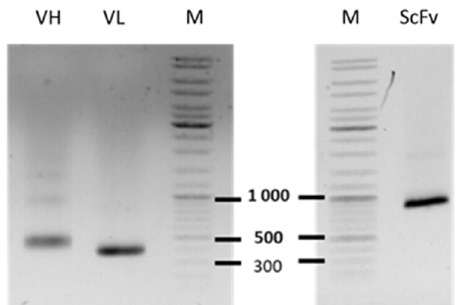
Figure 2. Visualization of PCR products on agarose gel (1.2% w / v ). VH: VH-ScFv PCR-purified product obtained after 3 rounds of PCR. VL: VL-ScFv PCR-purified product obtained after three rounds of PCR. M: Size marker 10 Kbp to 100 bp. ScFv: complete PCR insert VH + linker + VL after purification.